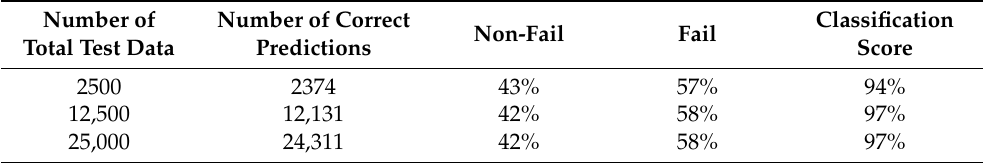
Table 2. Predictions made by the developed NN versus test data samples. It is worth mentioning that the test dataset used to validate the NN model represents 25% of total data